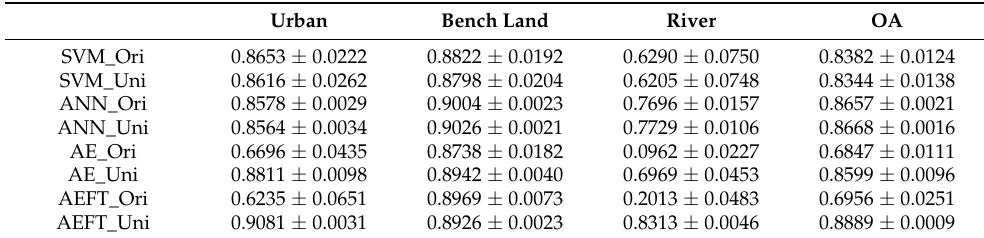
Table 10. Objective evaluation indicators of four classifiers on the normalized parameters and the original parameters of Touzi decomposition for Xi’an area.